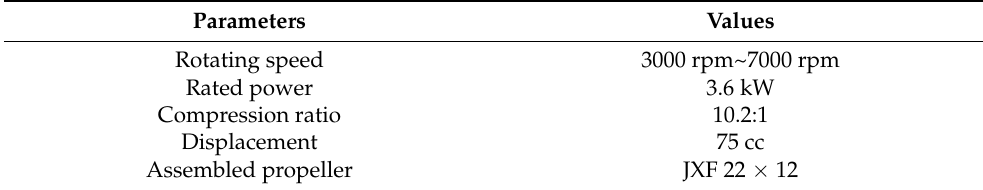
Table 2. Engine performance parameters.